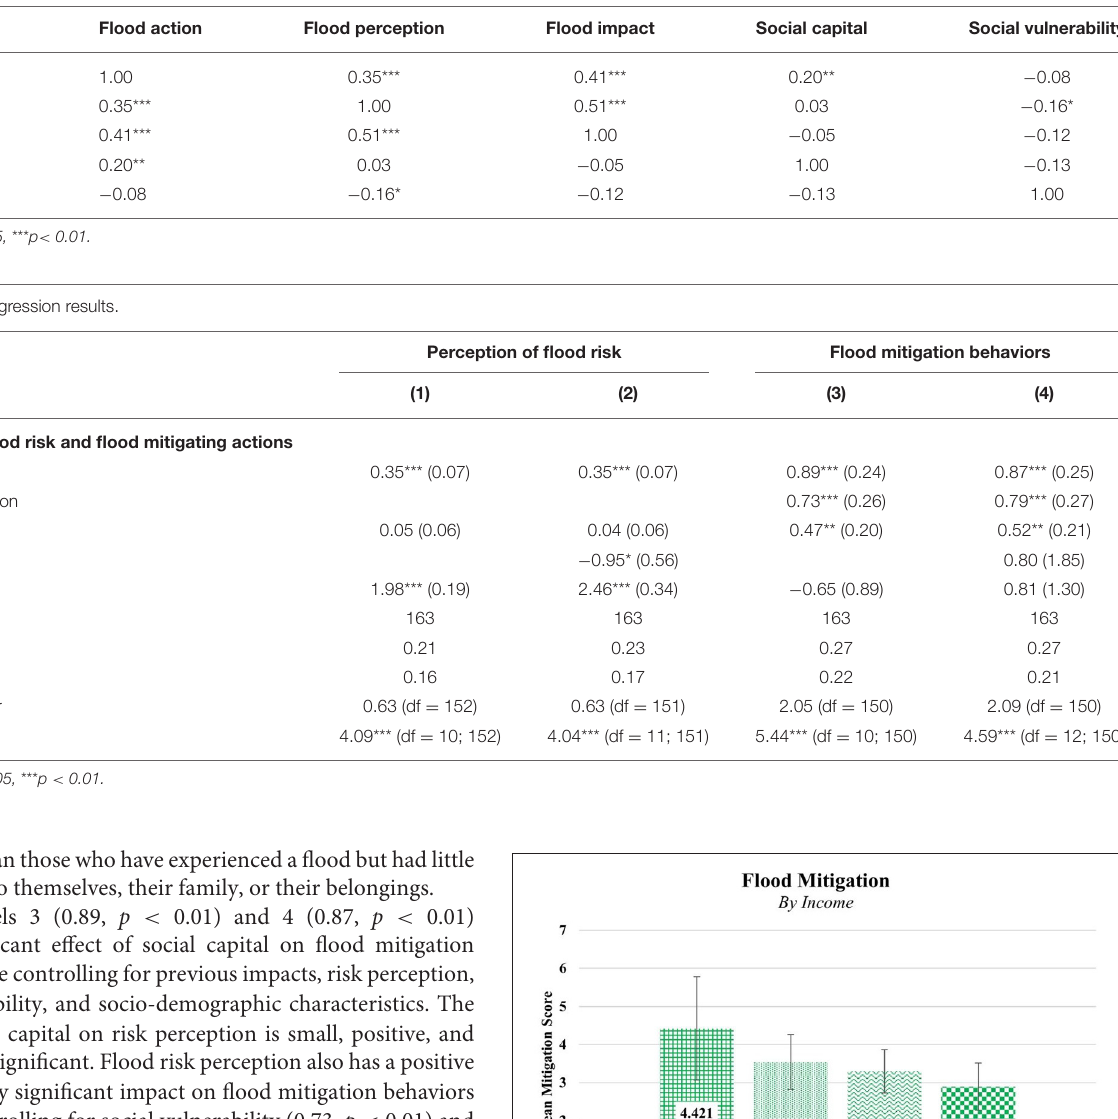
TABLE 3 | Correlation matrix of model variables.